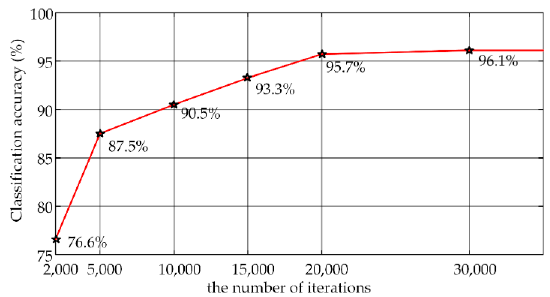
Figure 9. Impact of the iteration number on the results.